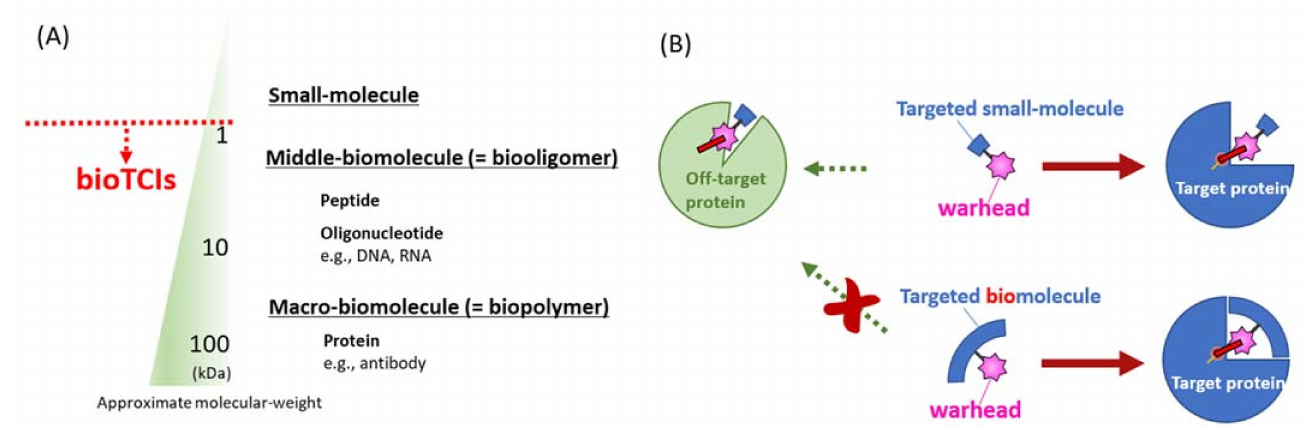
Figure 1. Reported modalities of targeted covalent inhibitors (TCIs). ( A ) Different TCI modalities are categorized as small, middle, or macro-molecules according to their molecular mass. This clas- sification by the molecular mass is not absolute, with many overlaps. Peptidic and nucleotidic aptamers discussed in this review are defined as middle-molecules by such a molecular mass classifi- cation. ( B ) The most distinguishing difference between conventional small-molecular TCIs (upper) and bioTCIs (lower). Because of the multi-point recognition of the target protein by the bioTCI, off-target covalent conjugation toward target-unrelated protein will be suppressed. The cost for the stringent target recognition via the molecular-weight increase of bioTCIs is the difficulty in inhibiting intracellular proteins because of the limited membrane permeability.